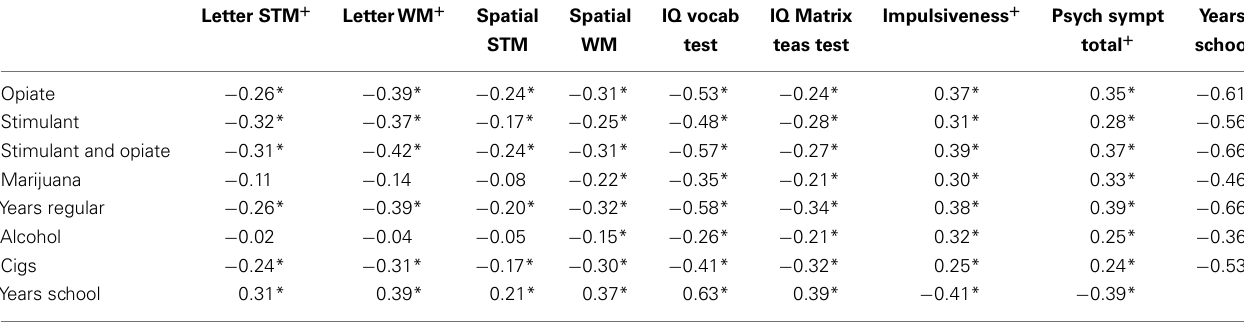
Table 2 | Drug use, cognition, psychological disposition, and years-of-school correlations*